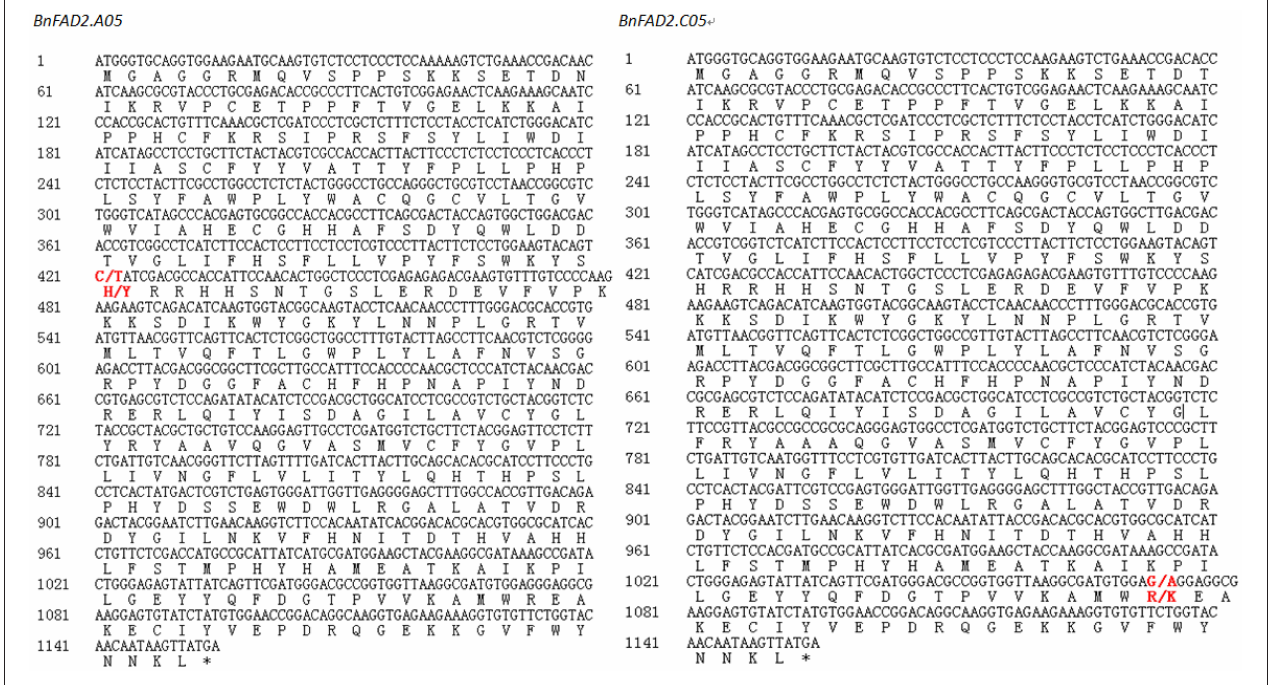
FIGURE 3 | Nucleotide and protein sequence of BnFAD2.A05 and BnFAD2.C05 containing single nucleotide polymorphisms (SNPs) resulting in high oleic acid content in Brassica napus . Red bold font represented the positions of the SNP sites, marked as “wild type/mutant”.